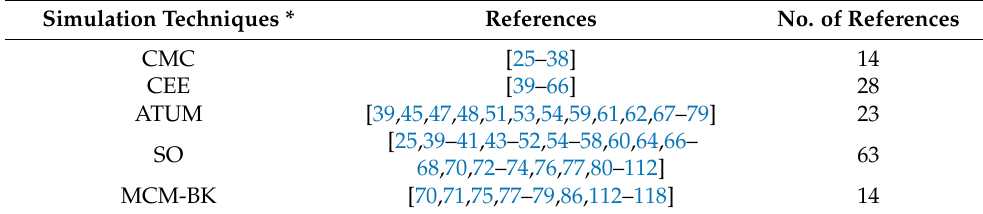
Table 1. Classification of the reviewed papers—simulation techniques. Simulation Techniques